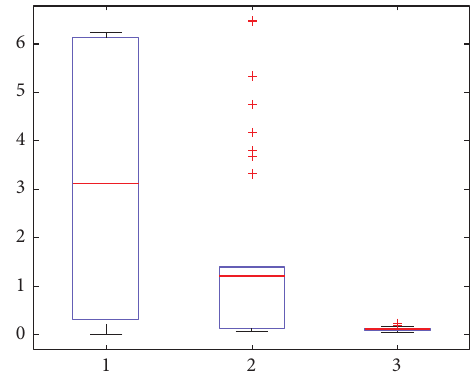
Figure 4: Box plots of the RMSE for three